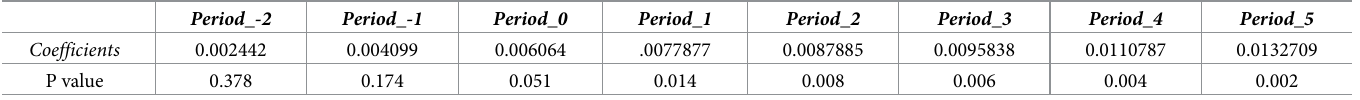
Table 10. Parallel trend test.